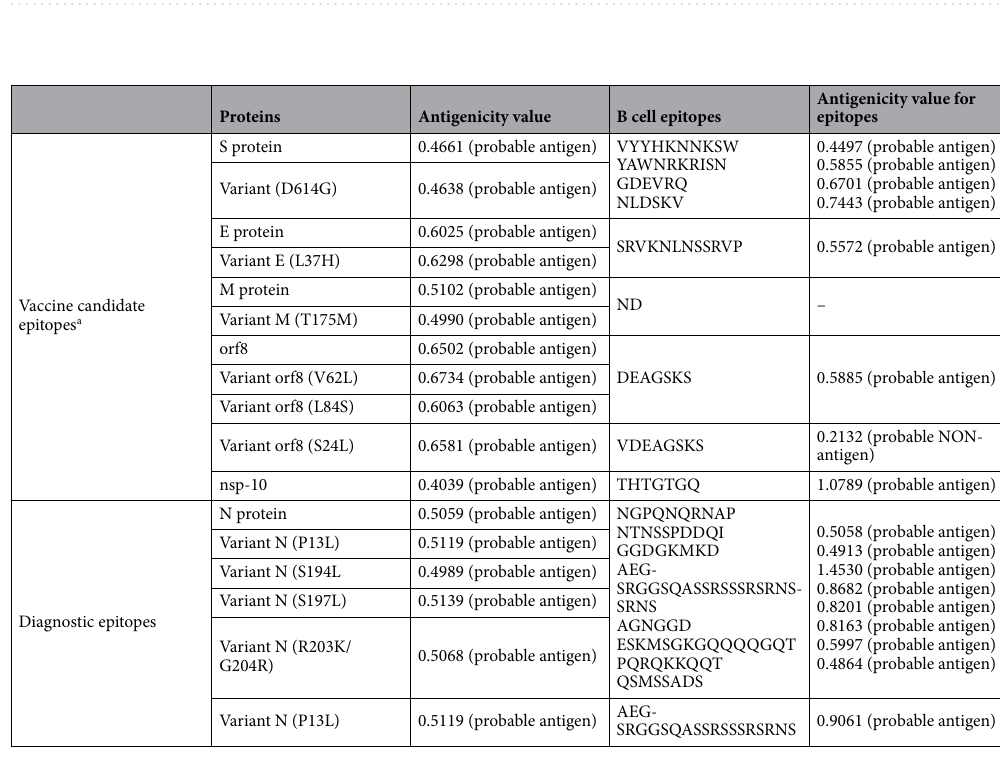
Table 6. B cell epitopes predicted by both Bcepred and IEDB and antigenicity value predicted by Vaxijen v2.0. ND not detected. a Vaccine candidate epitopes can also be used to develop serodiagnostic